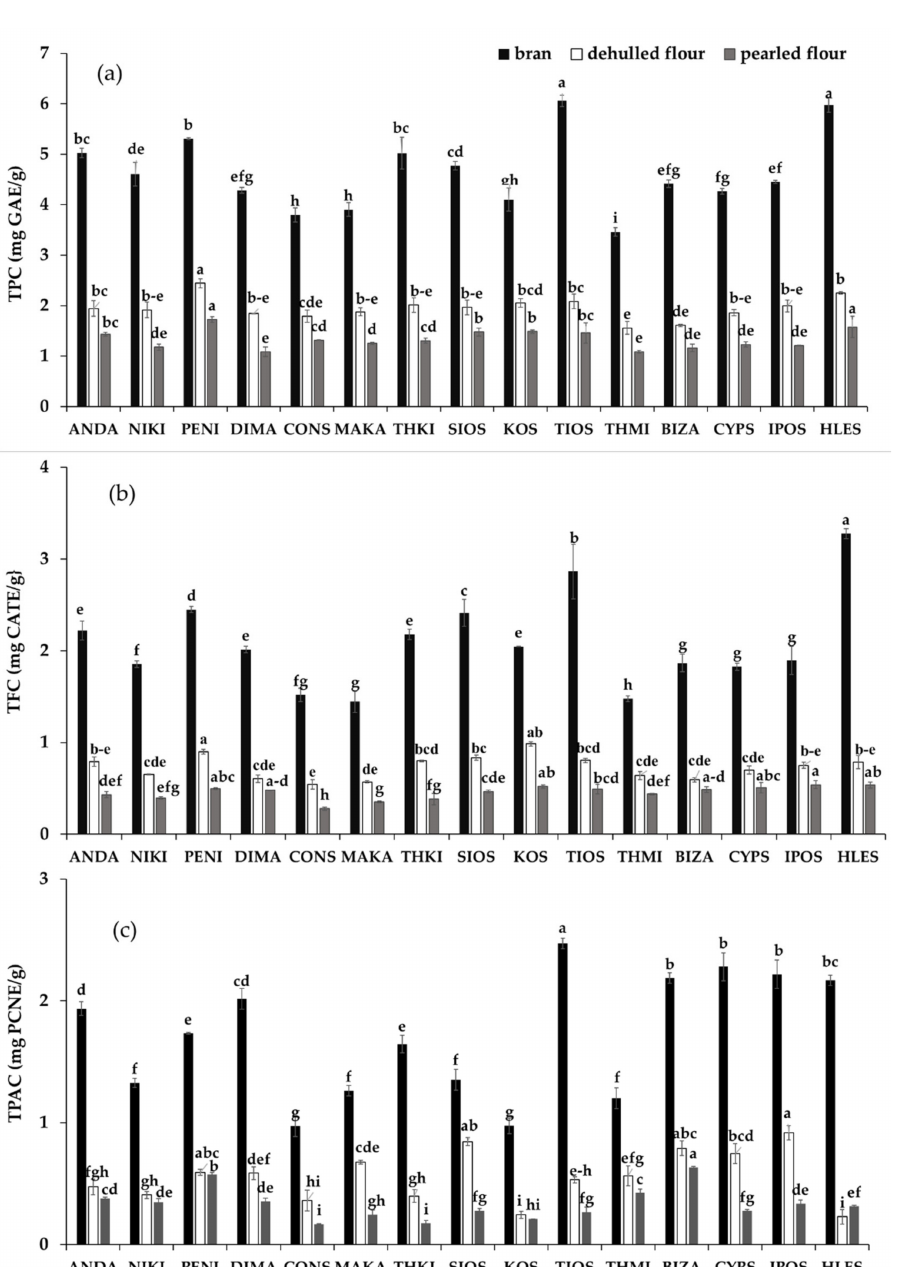
Figure 2. Total phenol content ( a ), total flavonoid content ( b ), total proanthocyanidins content ( c ) of fractions (bran, dehulled four, pearled flour) of barley cultivars. Bars with no letter in common are significantly di ff erent from each other ( p ≤